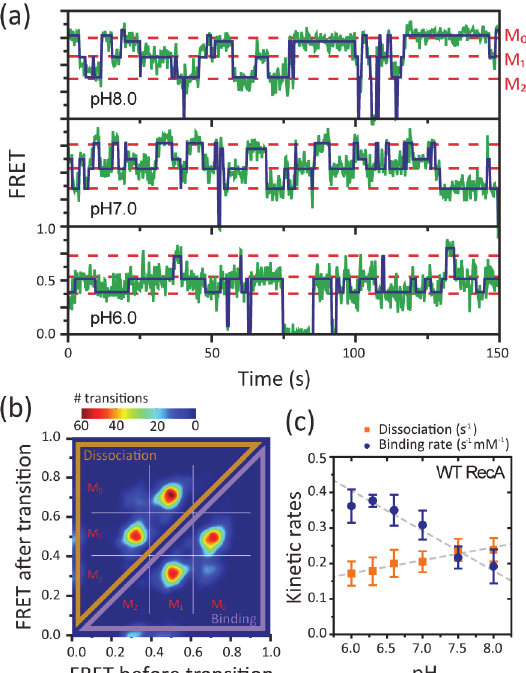
Figure 2. Real-time observation of monomer binding and dissociation events. (a) Representative FRET time traces measured at pH 8.0, pH 7.0, and pH 6.0 (green solid lines) with most likely FRET values assigned by hidden Markov modeling (dark blue solid lines). (b) A representative transition density plot (TDP) measured at pH 7.0. 7,560 transitions were identified by the hidden Markov modeling from 94 molecules. The transitions were classified into four groups: two for monomer binding and two for monomer dissociation. (c) The binding (blue) and dissociation (orange) rates as a function of pH measured with wild type RecA. The error bars are standard deviations from three independent measurements. The slopes obtained by linear fit (dashed lines) to the dissociation rates and the binding rates are 0.05 and − 0.10,